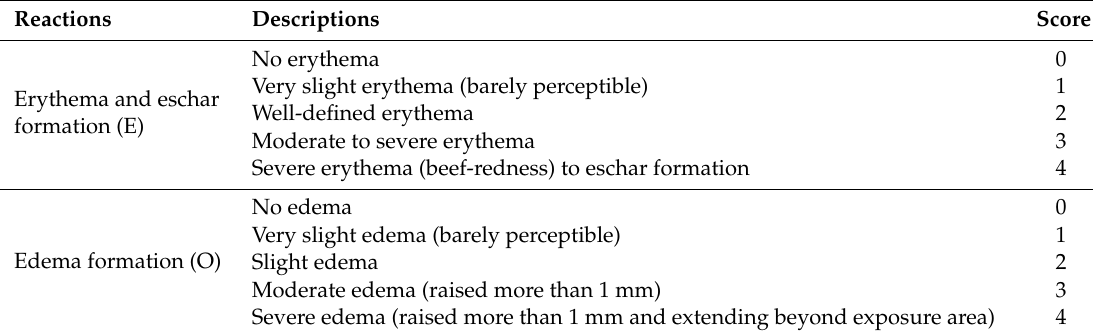
Table 2. Grading of the skin